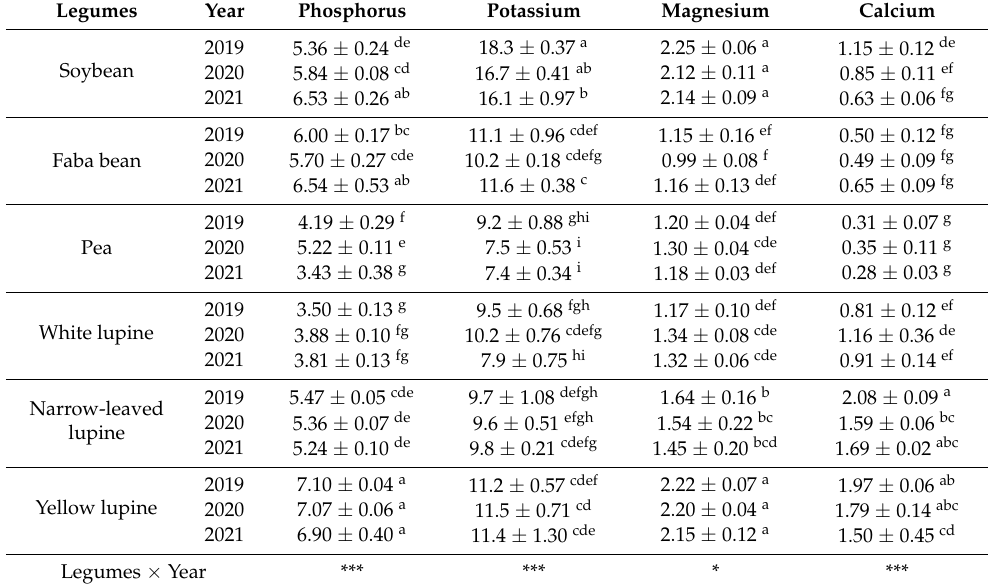
Table 3. Macronutrient contents in seeds (g kg − 1 DM). Legumes